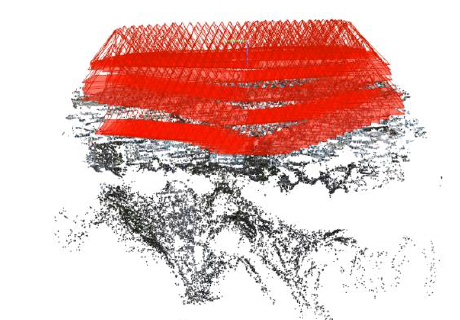
Figure 9. Aerotriangulation process of UAV images in Colmap.